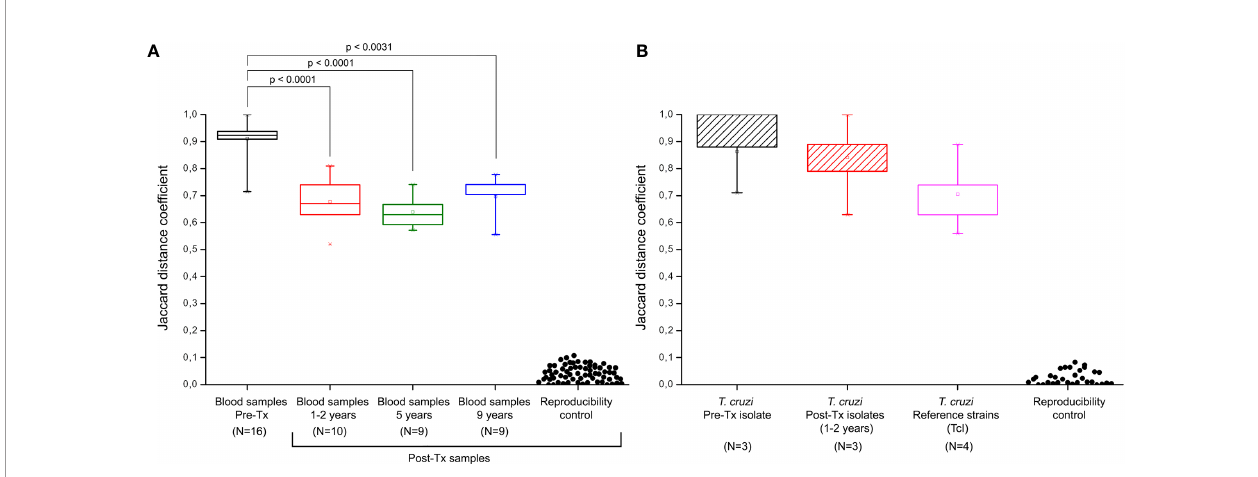
FIGURE 5 | Jaccard distances of minicircle signatures in parasite populations by kDNA-PCR restriction fragment length polymorphism (RFLP). (A) Jaccard distances from bloodstream parasites populations in patients of the Chichiriviche de la Costa outbreak. (B) Jaccard distances of the hemocultures from the Chichiriviche de la Costa outbreak and TcI reference strains. Reproducibility controls were obtained by comparison of signatures between duplicate samples. Tx: treatment. The JC results shown in the box “ reference strains ” were obtained from the comparison of the Ms from the Dm28c, SilvioX10, gal4, and CMA strains. P values indicate signi fi cant differences between populations (Mann-Whitney U test; p<0.05). Data in the boxplot are presented as median and interquartile range of 25 to